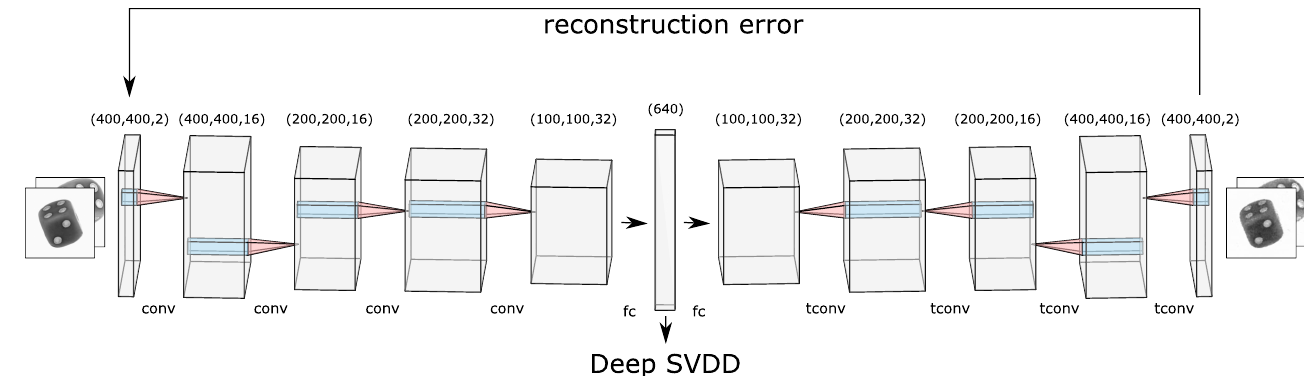
Figure 1. Illustration of the convolutional autoencoder used for multi-perspective anomaly detection. There are five layers each in the encoder and decoder block. Each layer can be identified with a particular name (“conv” for convolution, “tconv” for transpose convolution, and “fc” for fully connected) and the size that it outputs. The arrow towards Deep SVDD portrays that this is used as the feature space where the hypersphere is found. Figure partly generated with LeNail’s schematics